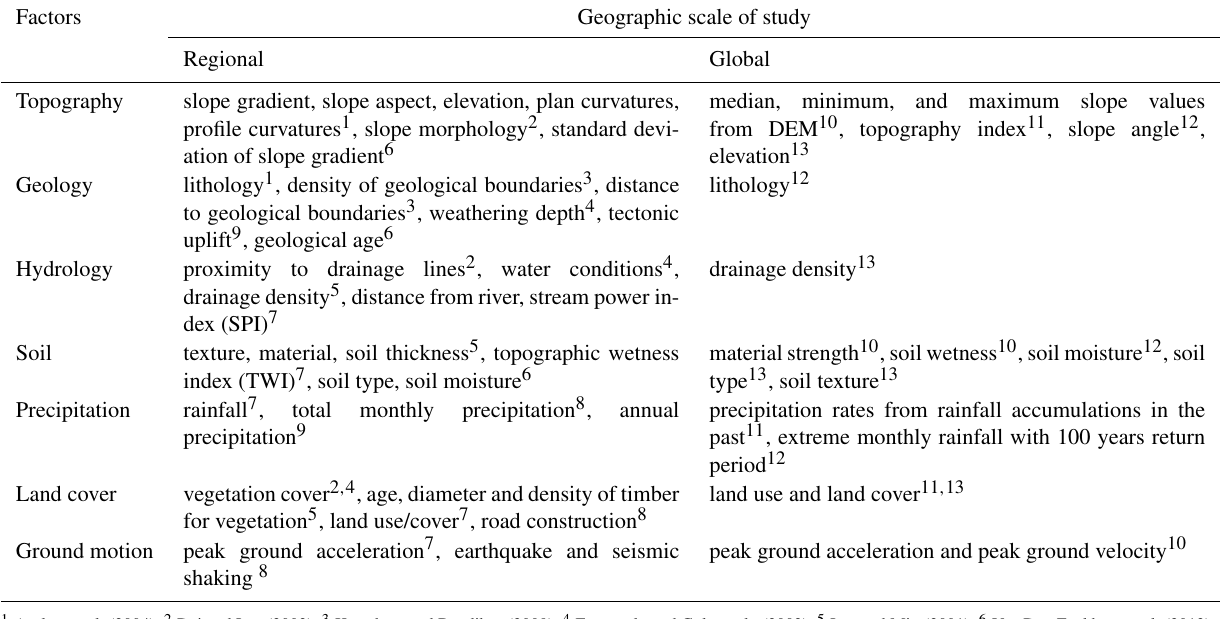
Table 1. Brief summary of explanatory factors in landslide susceptibility assessment for regional scale and global scale. Numbers in the table indicate related